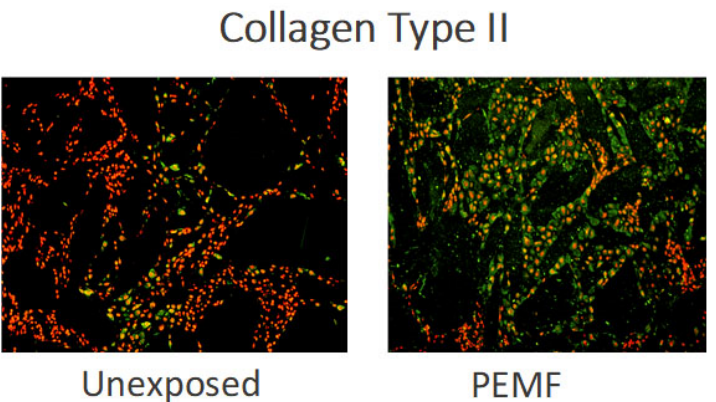
Figure 6. Fluorescein immunohistochemistry of type II collagen during chondrogenesis (day 8 of ossicle development). Black areas are DBM particles. Nuclei are stained red with propidium iodide. Fluorescein stained type II collagen ECM and chondrocytes (green) are more prominent in PEMF-exposed ossicles compared to unexposed ossicles [65].